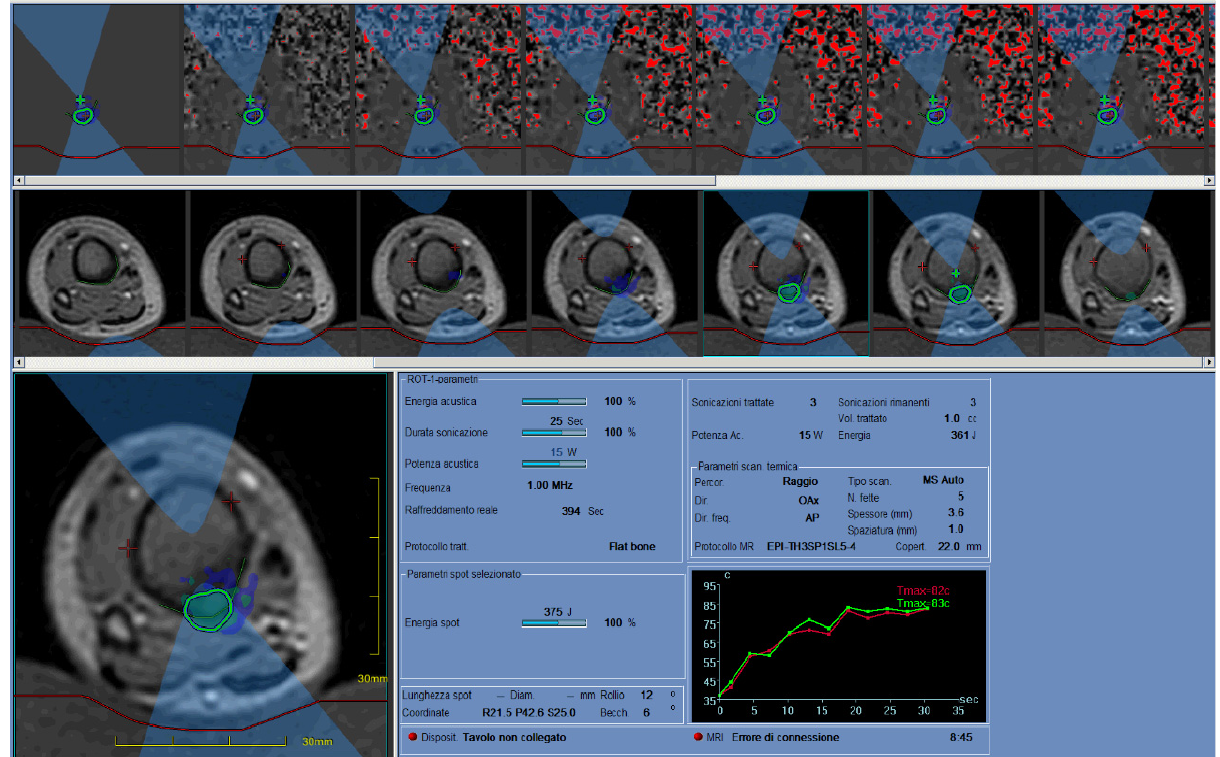
Figure 3. Tibial OB treated with MRgFUS was successful thanks to the presence of an adequate acoustic window and the superficial position of the lesion. Specific MR-sequences, acquired during the treatment, provided real-time thermometric maps of the region of interest to avoid thermal damage of the surrounding tissues.